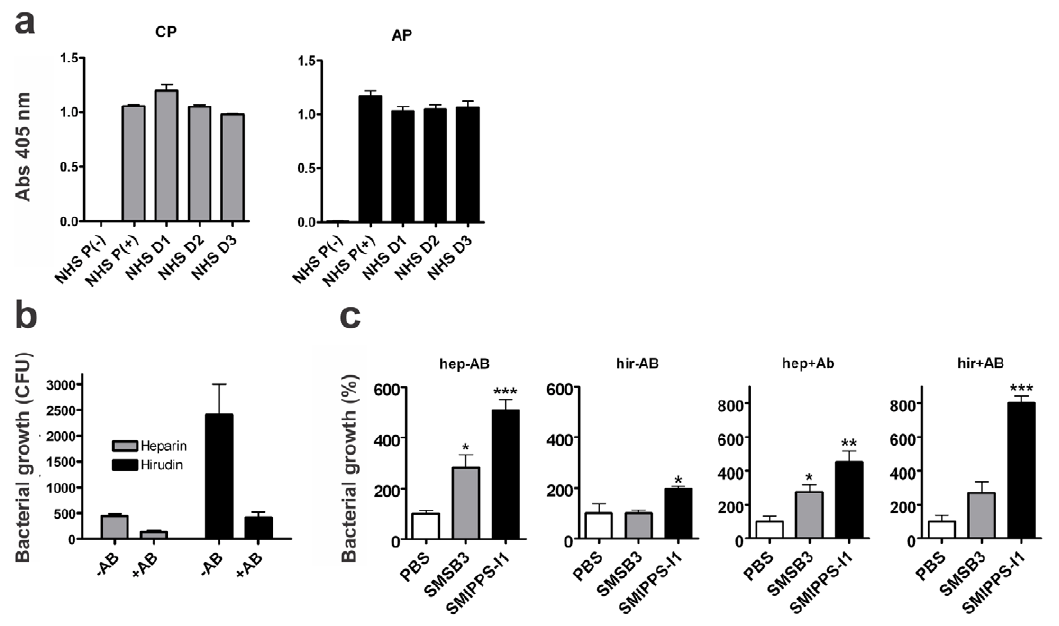
Figure 2. Assessment of donor blood and the role of anticoagulant and antibody levels in bactericidal assays. ( a ) The three human whole blood donors used in this study showed average complement activation levels representative of the normal population. Complement activation of the Classical (CP) and Alternative (AP) pathways was determined by ELISA. Shown are means 6 SEM of n=2 independent experiments, each performed in duplicate. NHS P( 2 ), inactivated; NHS P( + ), active normal human serum (n=8 donors); D1–D3, individual active serum donors. ( b ) Effect of anticoagulant on human whole blood bactericidal assays. Comparison of heparin- and hirudin-treated blood in bactericidal assays indicates that the anticoagulant heparin can alter complement activation at low concentrations, thereby affecting GAS growth. 6 AB, with and without addition of heat-inactivated anti-GAS sera containing type-specific antibodies; ( c ) Scabies mite proteins enhance bacterial growth in GAS bactericidal assays under all conditions tested. Protein concentrations of 200 m g/ml were used. Shown are means 6 SEM of n=4 experiments from one representative blood donor with low naı¨ve levels of anti-GAS antibodies. 6 AB, with and without addition of heat-inactivated anti-GAS sera; hep, heparin; hir, hirudin. *, p , 0.05; **, p , 0.01; ***, p , 0.001 by t test (GraphPad Prism